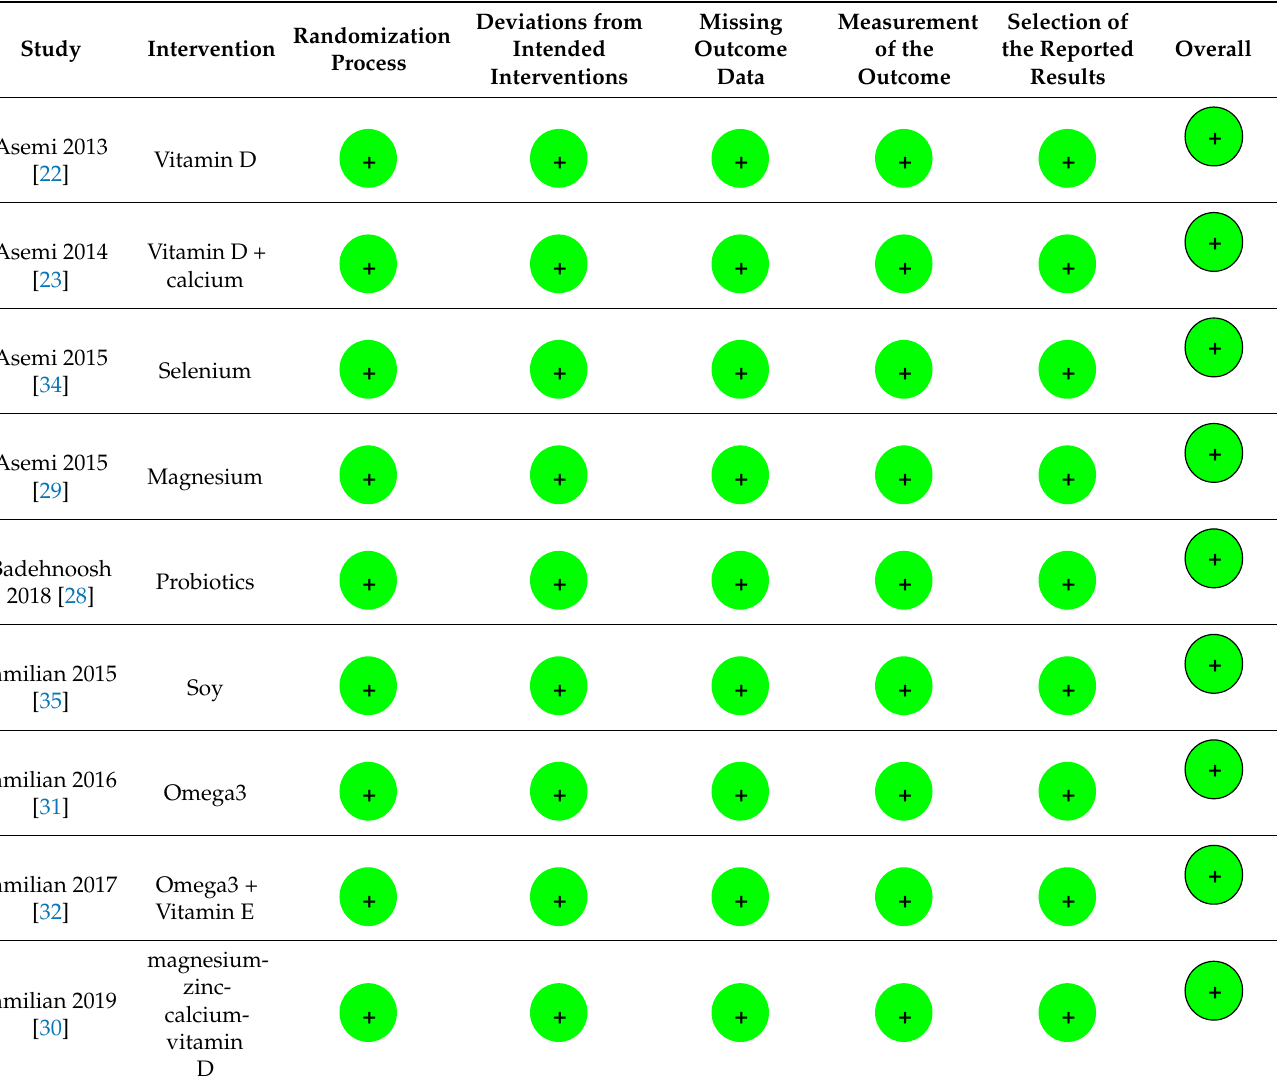
Table 2. Risk of bias of selected studies.